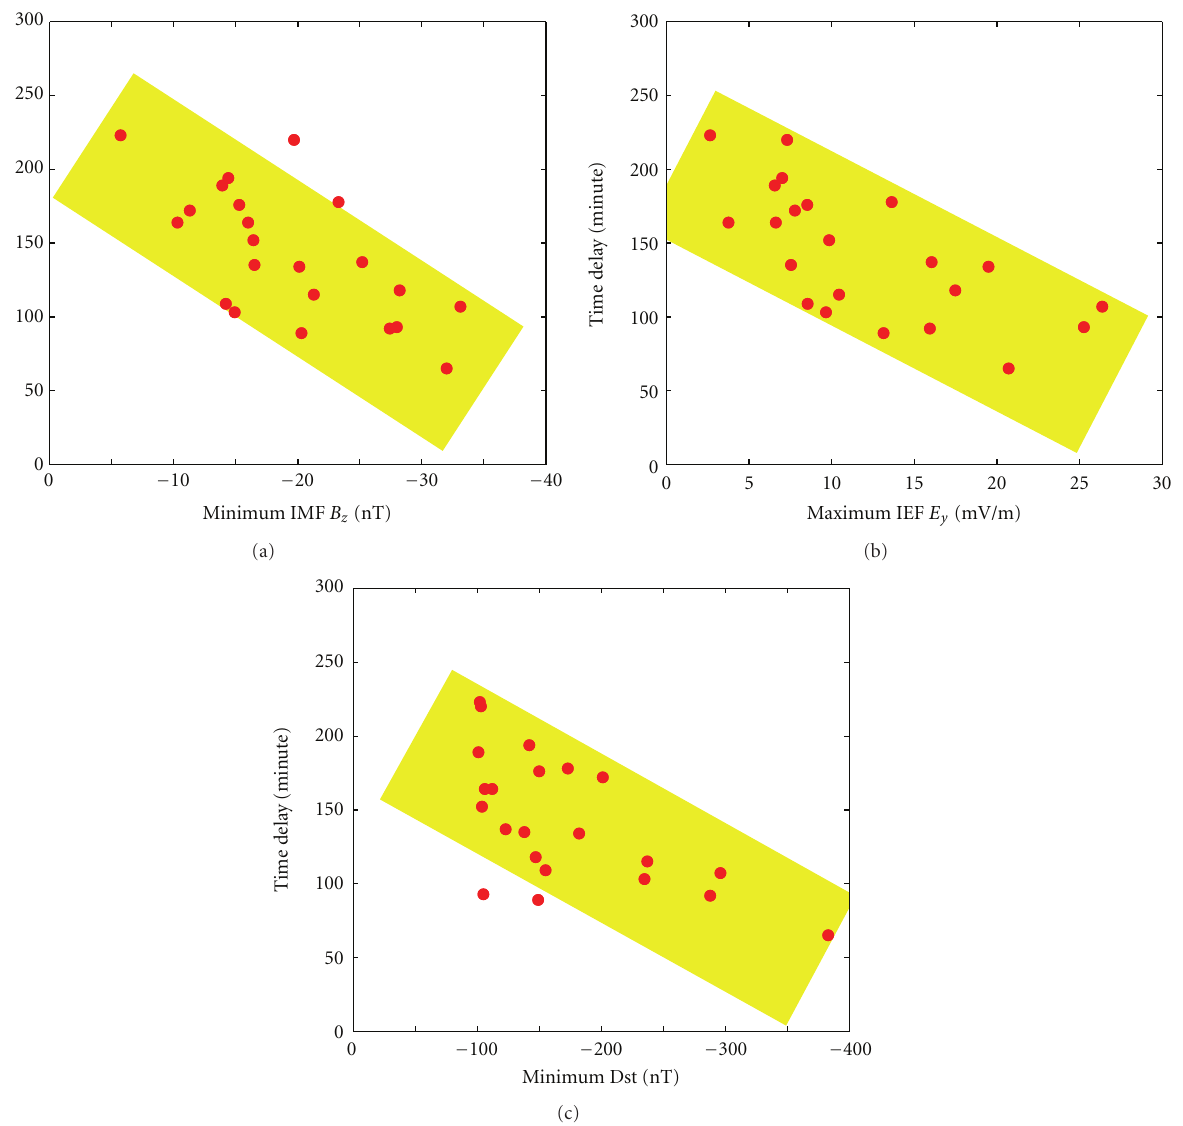
Figure 6: The time delay between IMF southward turning and first DMSP detection of equatorial plasma depletions as a function of (a) the minimum value of the IMF B z , (b) the maximum value of the IEF E y , and (c) the minimum Dst value during intense magnetic storms.